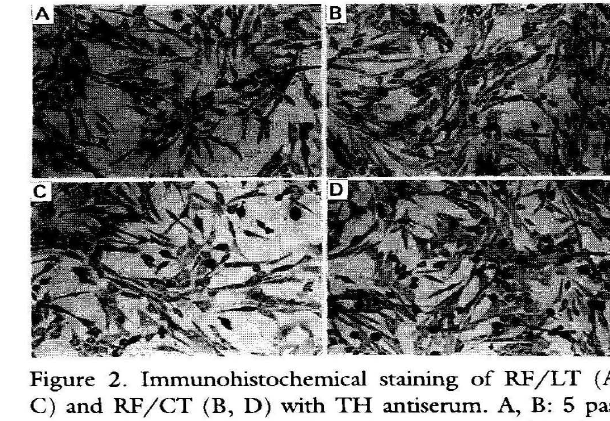
Table 1. L-DOPA production and release into